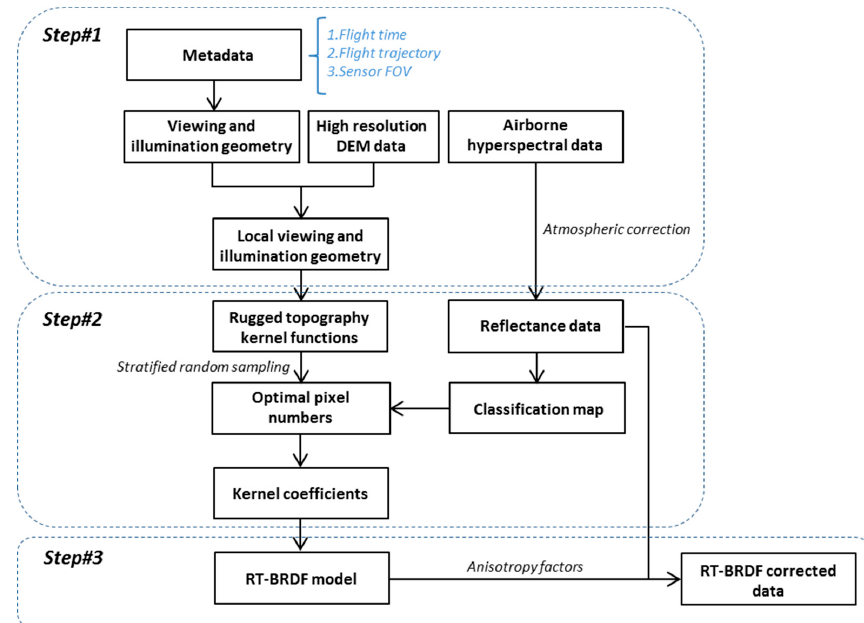
Figure 2. Workflow of the rugged topography-bidirectional reflectance distribution function (RT-BRDF) correction method.